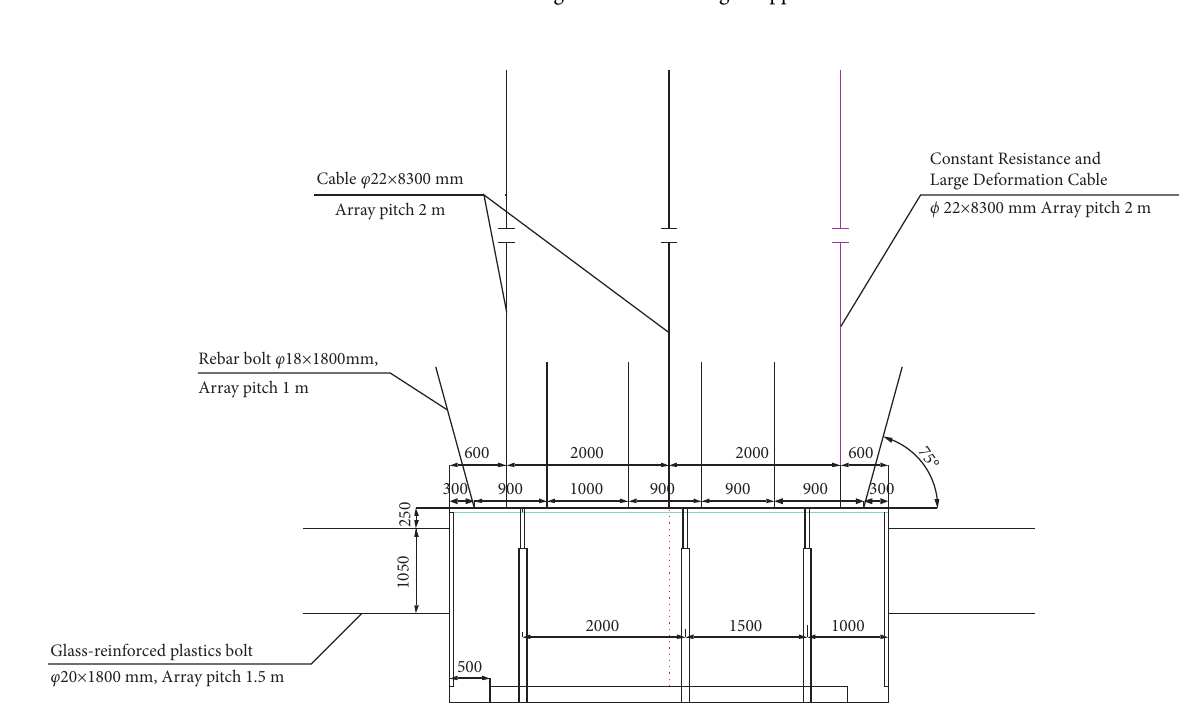
Figure 18: Sectional drawing of a single support in the